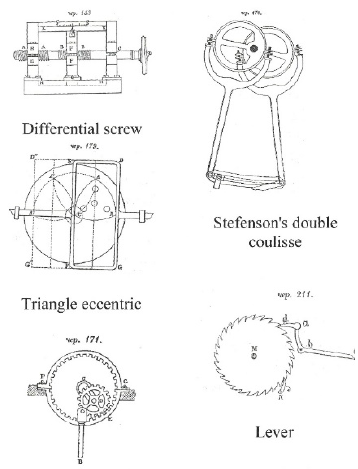
Figure 14. Examples of Moving Transmission